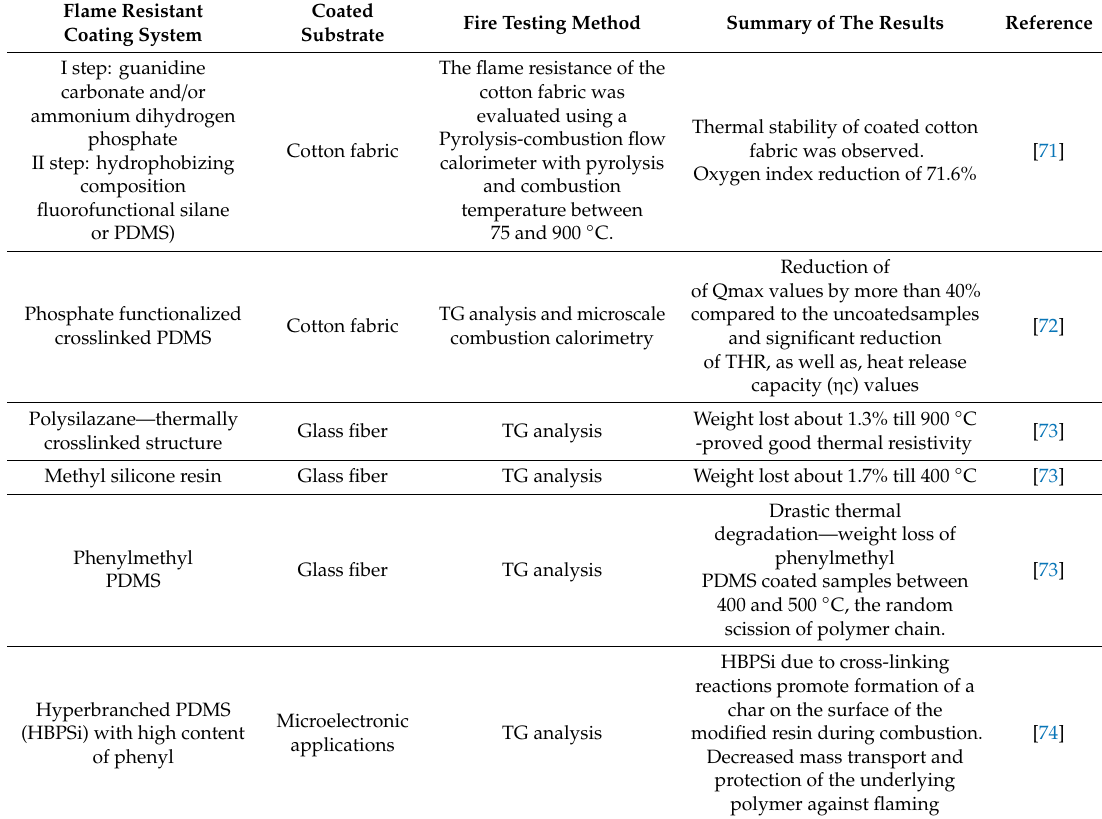
Table 2. The examples of the flame-resistant silicone-based